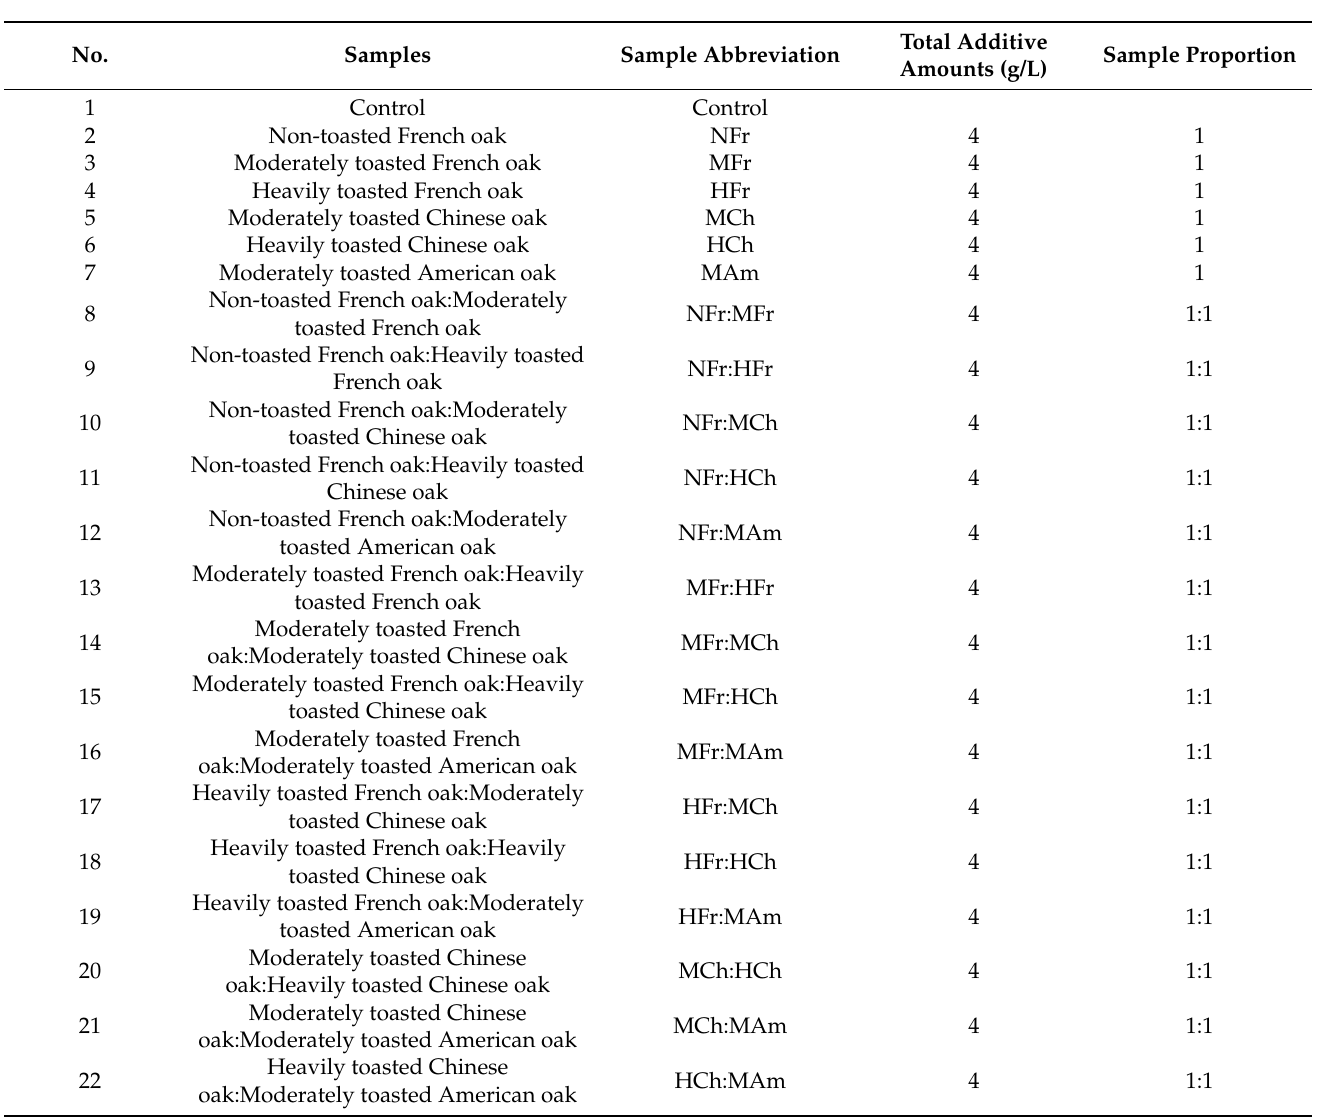
Table 1. Addition of the 21 oak chips to wines of Vitis amurensis, including different single oak chips and combined oak chips, dosage (4